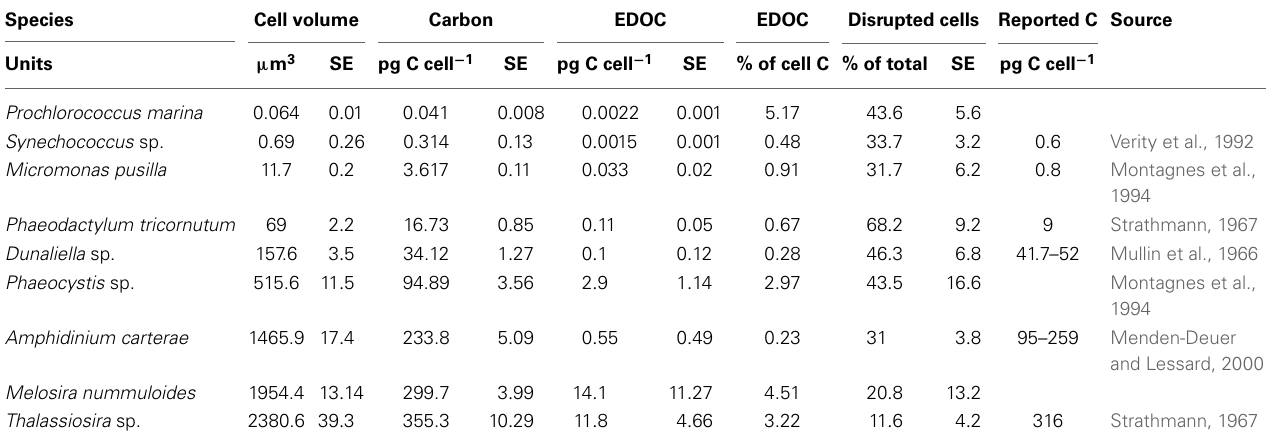
Table 1 | Cell volume, cell carbon content calculated using the equations from Verity et al. (1992), exchangeable cellular organic carbon content (EDOC), percentage of cellular C comprised by EDOC, percentage of cells ruptured by the mechanical procedure applied, and cellular carbon content derived from a compilation of previous studies that estimate carbon content from cell